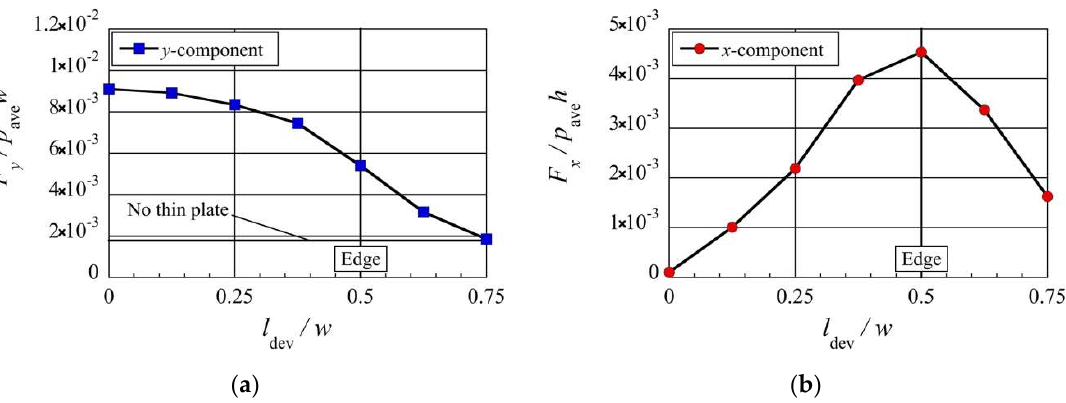
Figure 8. Net ( a ) upward and ( b ) rightward forces exerted on the beam for different deviation distances, 𝑙 (cid:2914)(cid:2915)(cid:2932) , at Kn = 0.2 .